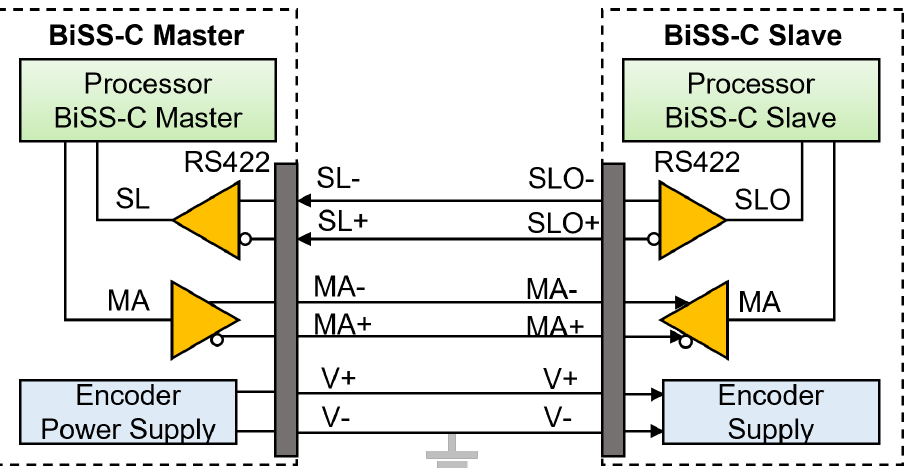
Figure 1. BiSS-C point-to-point communication